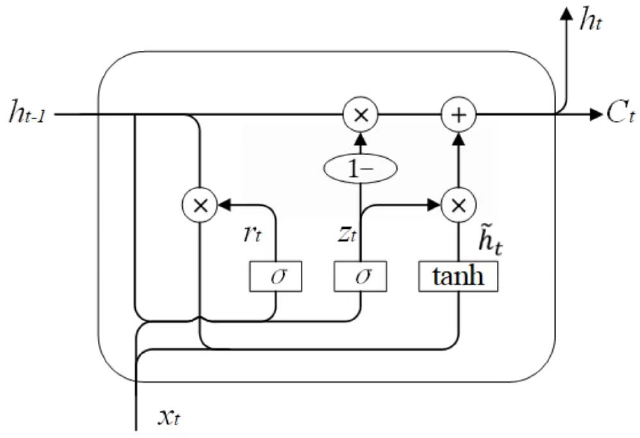
Figure 2. Structure diagram of GRU.